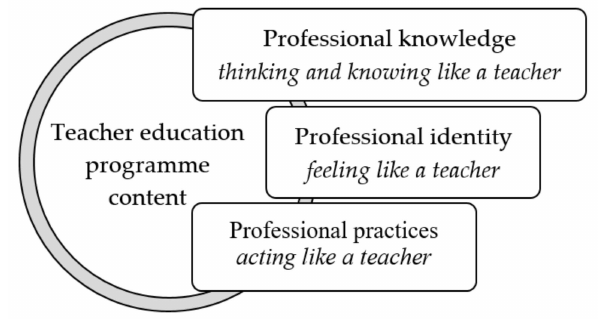
Figure 1. Content of initial mathematics teacher